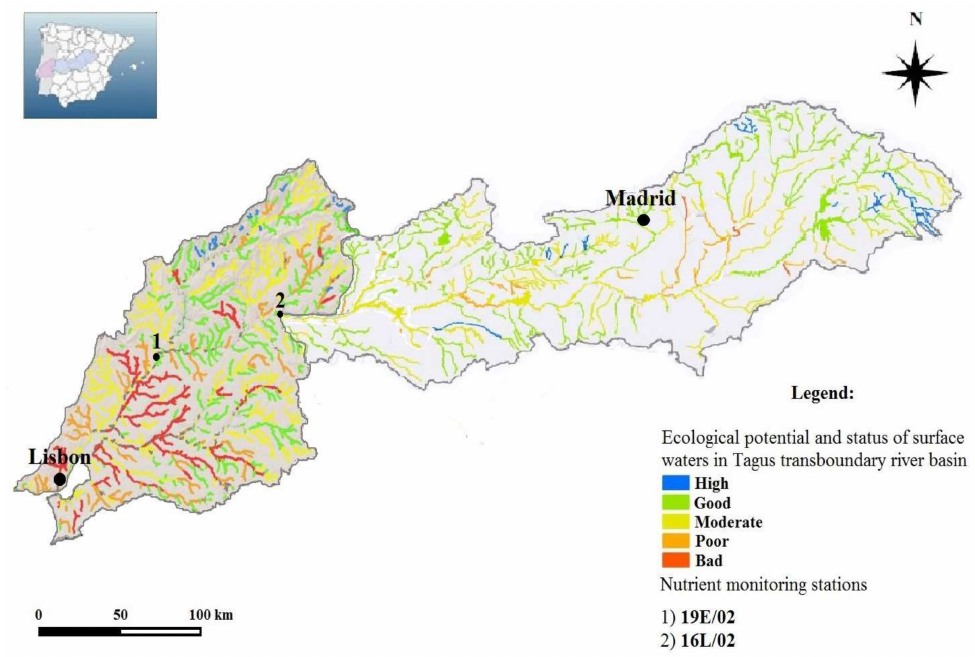
Figure 3. Surface waters ecological potential and status along Tagus watershed reported in 2015. N monitoring stations: (1) “Valada do Tejo” (code: 19E/02); and (2) “Monte Fidalgo – Cedillo” (code: 16L/02) (built with QGIS)